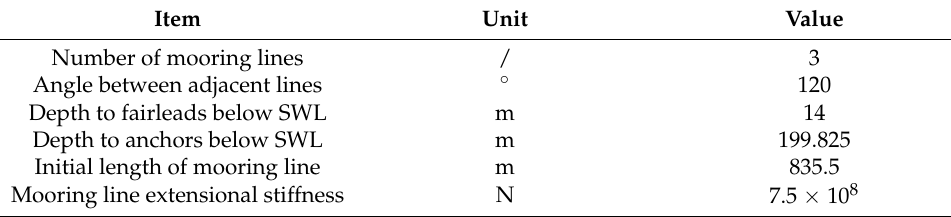
Table 3. Parameters of mooring system.